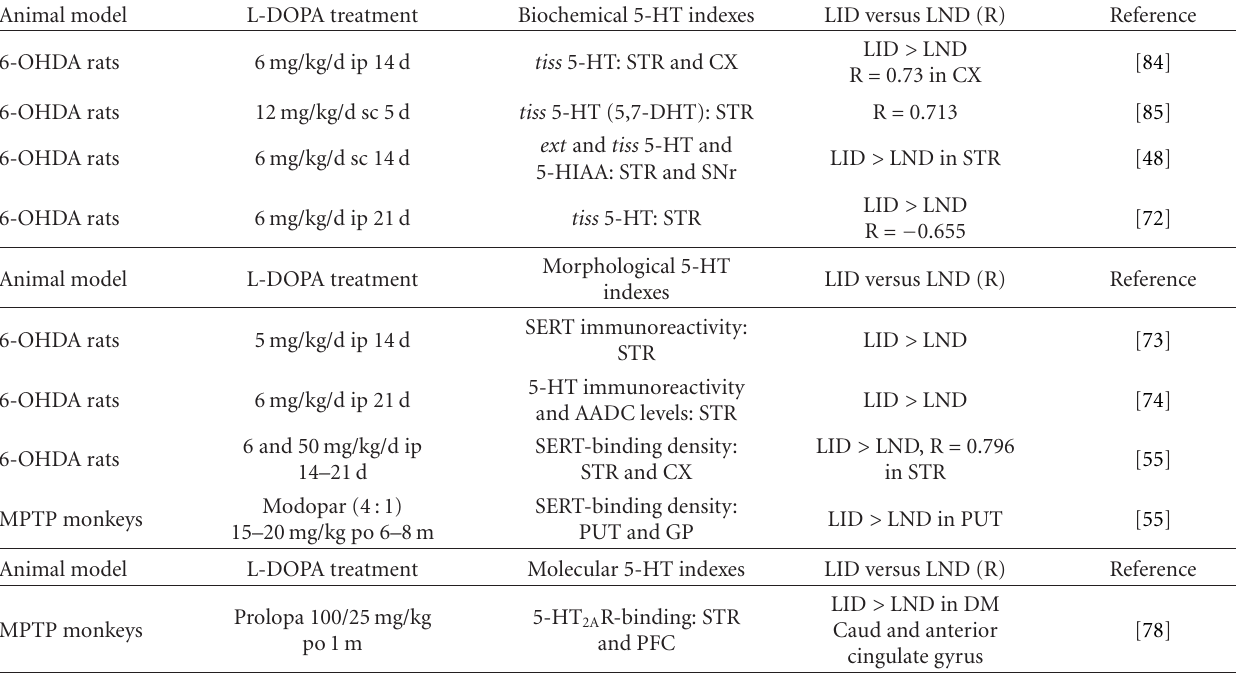
Table 2: Changes in biochemical, morphological, and molecular 5-HT indexes in dyskinetic (LID) versus nondyskinetic (LND) animals: correlation with dyskinesias